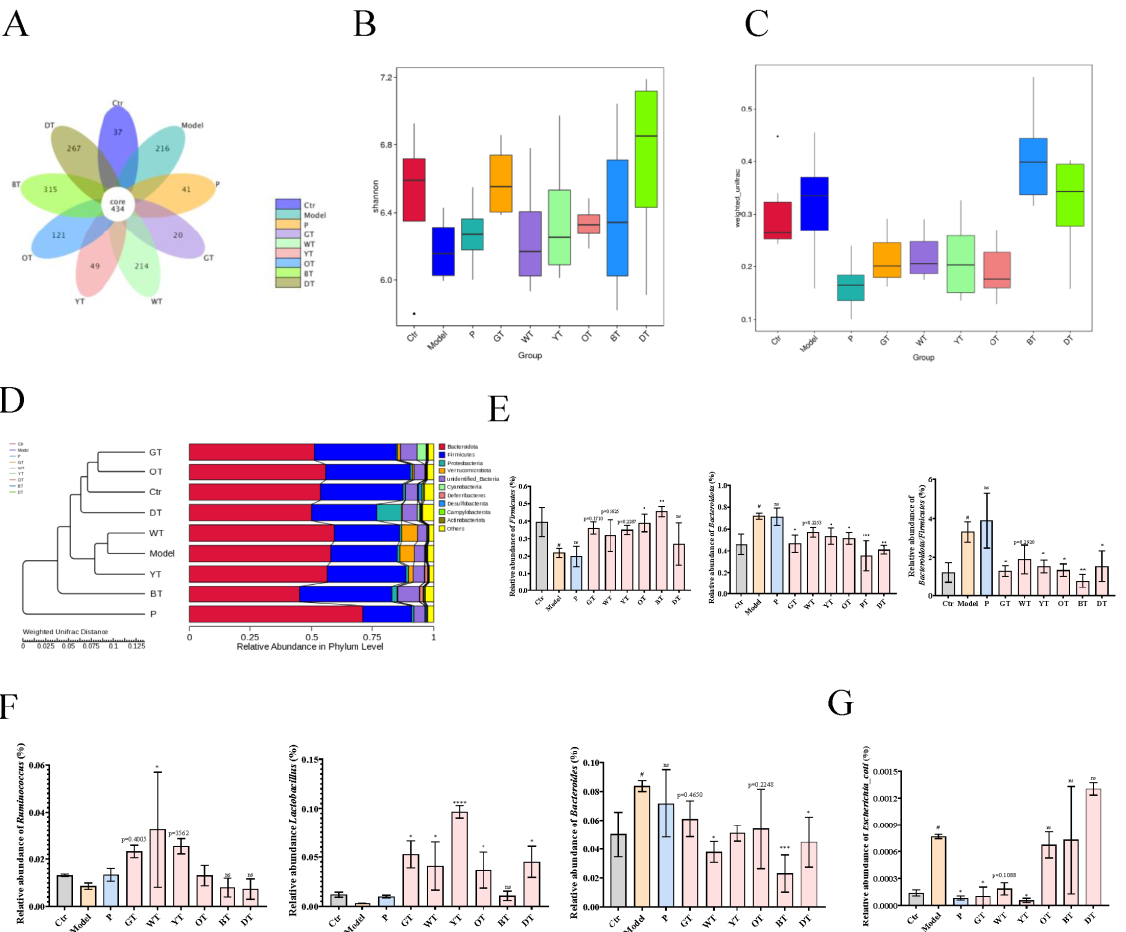
Figure 7. Effects of TWEs on gut microbiota in HUA mice. ( A ) Venn diagram showing species composition in nine groups. ( B ) Shannon index analysis of alpha diversity of nine taxa species’ intergroup difference analysis. ( C ) Boxplots based on weighted UniFrac beta diversity of nine taxa species. ( D ) Weighted UniFrac distance-based UPGMA clustering tree for nine taxa species at the phylum level. ( E ) Relative abundance of Firmicutes , Bacteroidota , and Firmicutes / Bacteroidota in